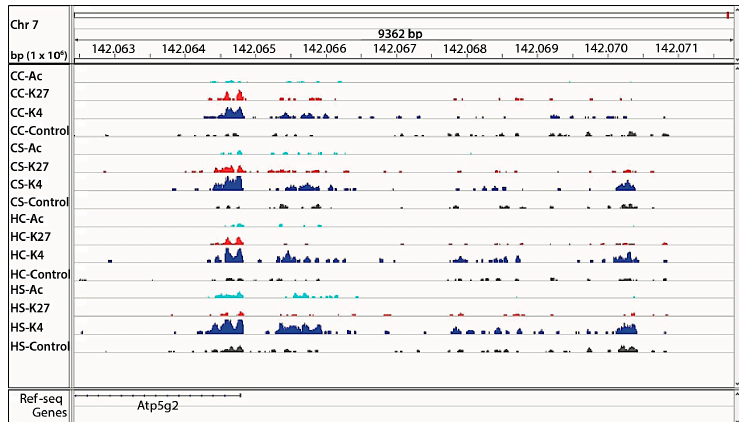
Figure A1. Peaks detection in ChIP sequencing: Representative genomic region of a negative strand (chromosome 7) near the transcriptional start site of Atp5g2 gene, illustrating 5 kb upstream peaks in cyan (acetylation), red (H3K427me3), blue (H3K4me3), and grey (Input control) colors. CC, controls; CS, diabetes exposed; HC, HF-diet exposed; HS, HF-diet and diabetes exposed or combination exposed. Nutrients 2017 , 9 , x FOR PEER REVIEW